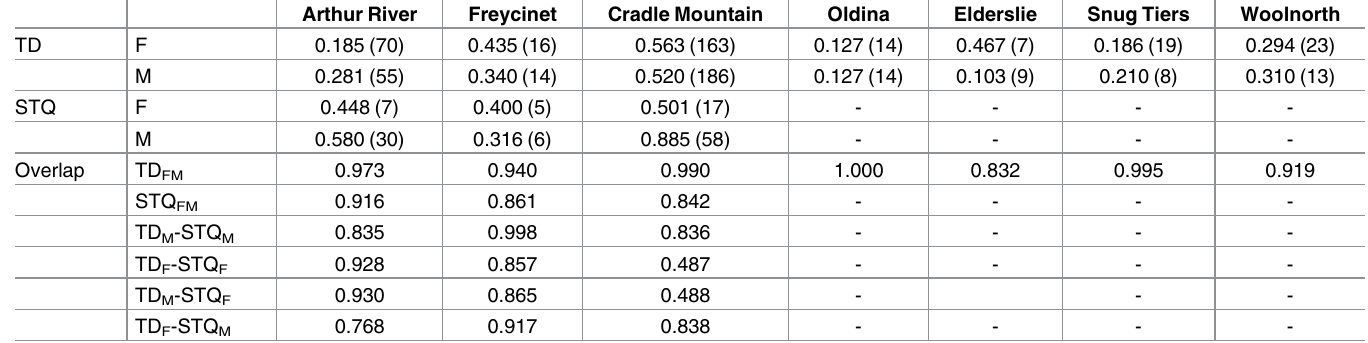
Table 4. Trophic niche breadth (Levins’ index) for each sex (F = Females and M = Males) of Tasmanian devils (TD) and spotted-tailed quolls (STQ) and diet overlap (Pianka’s index) for each combination of sexesand species. Number of scats (n) for each sex at each site is includedin parentheses.